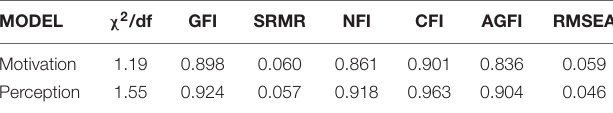
TABLE 1 | Adjustment indices of the FIT-choice scale.